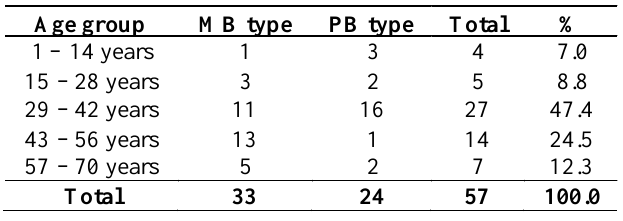
Table I: Age structure of study population according